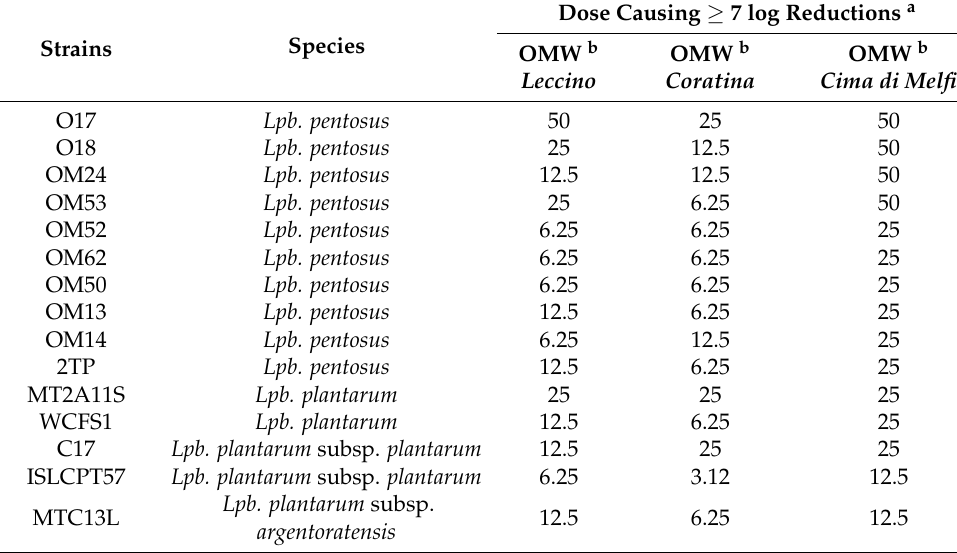
Dose Causing ≥ 7 log Reductions a OMW b OMW b OMW b Leccino Coratina Cima di Melfi